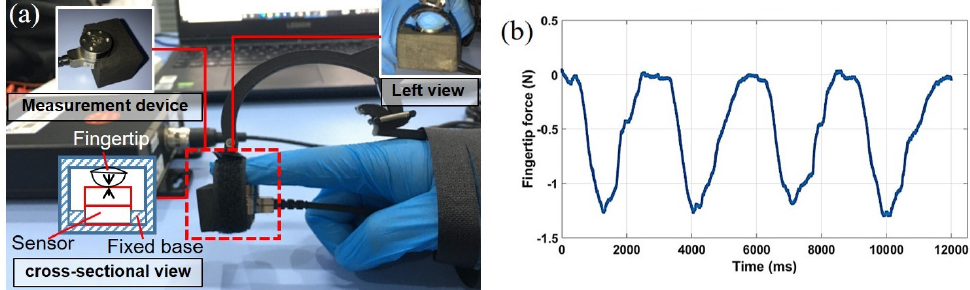
Figure 16. Fingertip force in free-space flexion. ( a ) The principle of the measurement device. ( b ) Fingertip force.